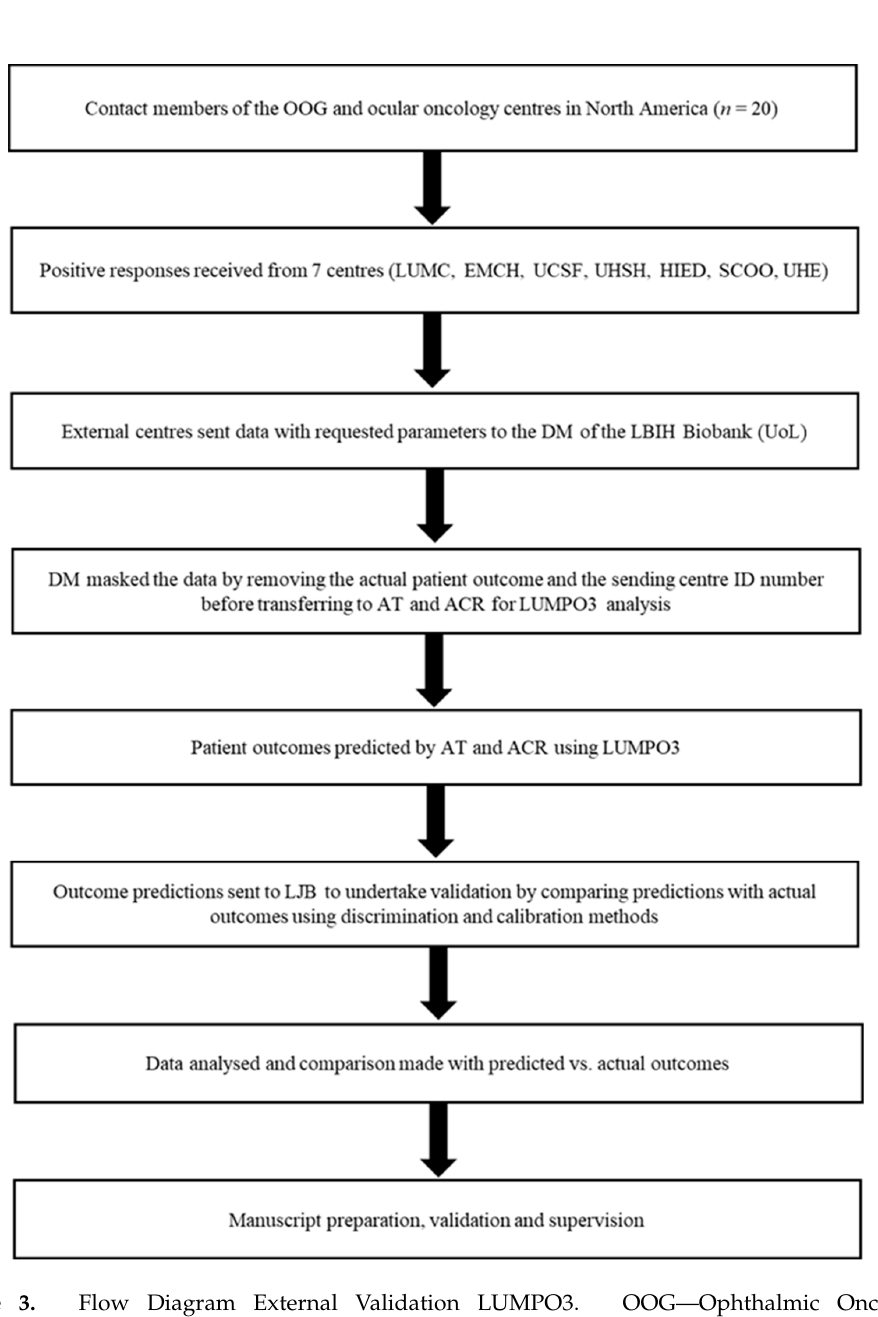
Figure 3. Flow Diagram External Validation LUMPO3. OOG—Ophthalmic Oncology Group,